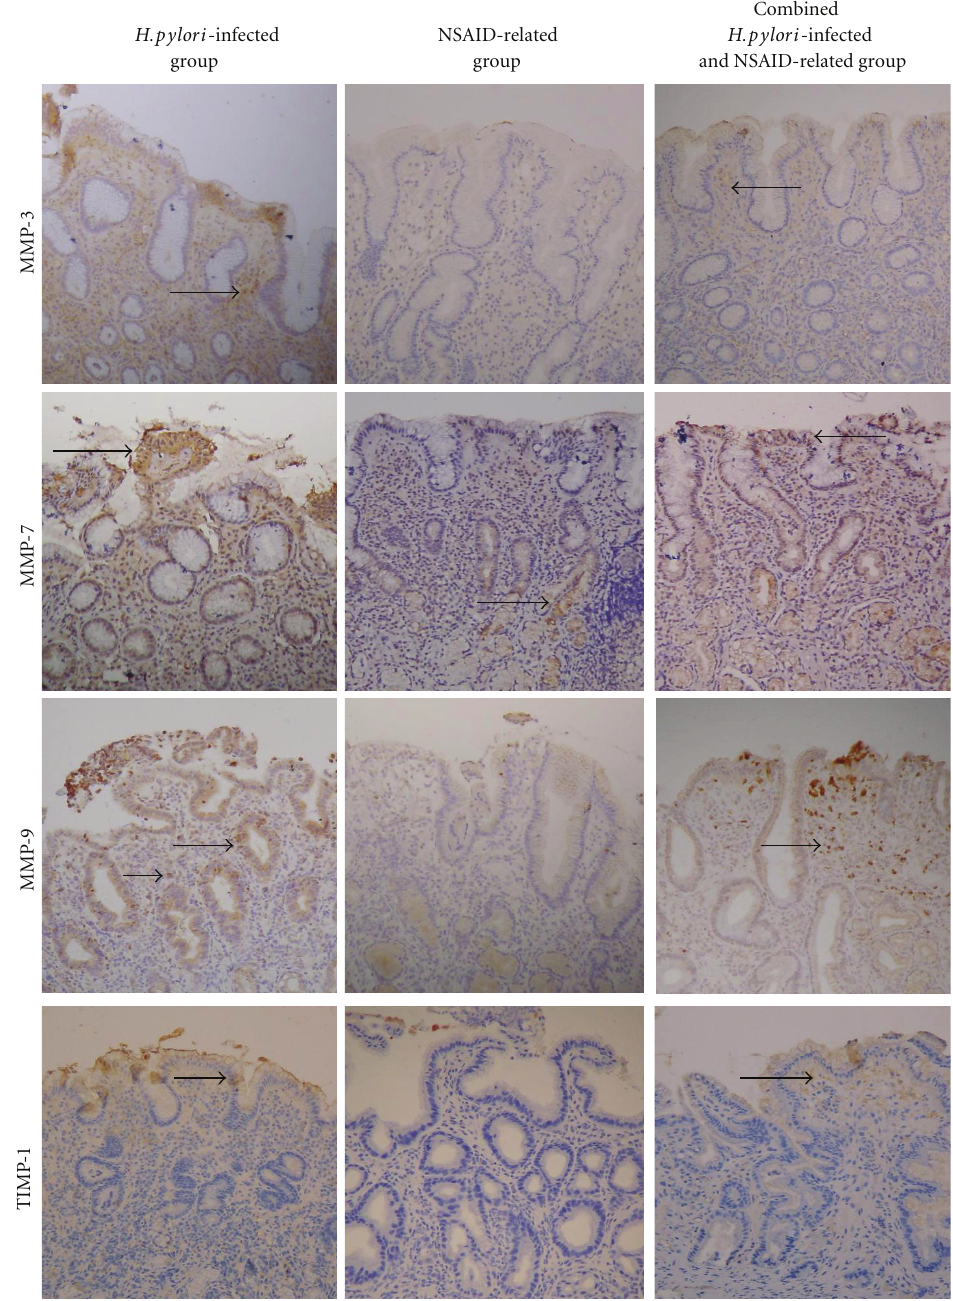
Figure 1: The immunohistochemical stains for matrix metalloproteinase (MMP)-3, -7, and -9 and tissue inhibitor of matrix metalloproteinase (TIMP)-1 in the Helicobacter pylori- ( H. pylori- ) infected group, in the nonsteroidal anti-inflammatory drug- (NSAID-) related group, and in the combined H. pylori -infection and NSAID-use group, in superficial epithelial cells and inflammatory cells of the lamina propria of gastric tissues (600x). H. pylori- infected gastric ulcers express higher MMP-7, MMP-9, and TIMP-1 than NSAID-related ulcers. Arrows indicate positive